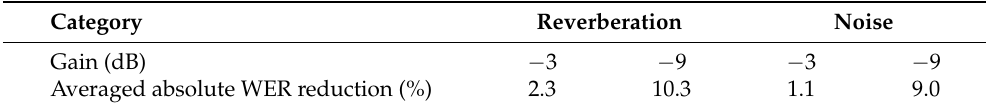
Table 1. Averaged absolute WER reduction of the proposed MOST gain control strategy relative to the current strategies. Category